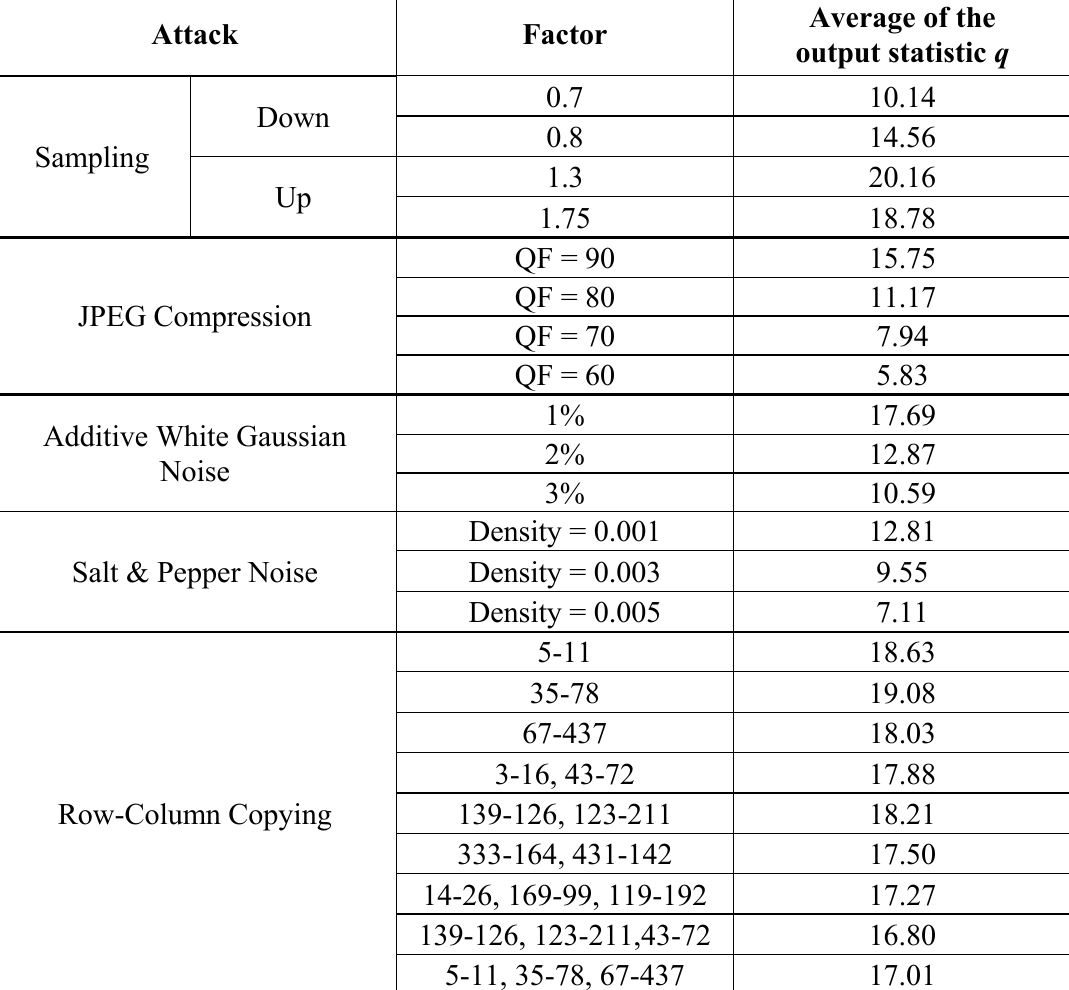
Table 2. Robustness of the proposed scheme against common attacks (acceptance threshold T =